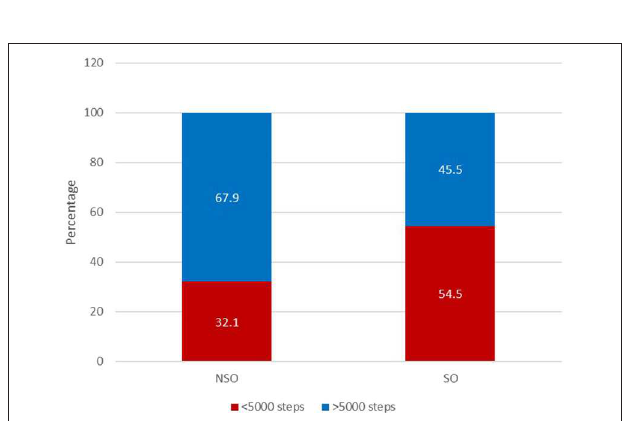
FIGURE 1 | Mean daily steps among patients with or without SO ( n = 111).